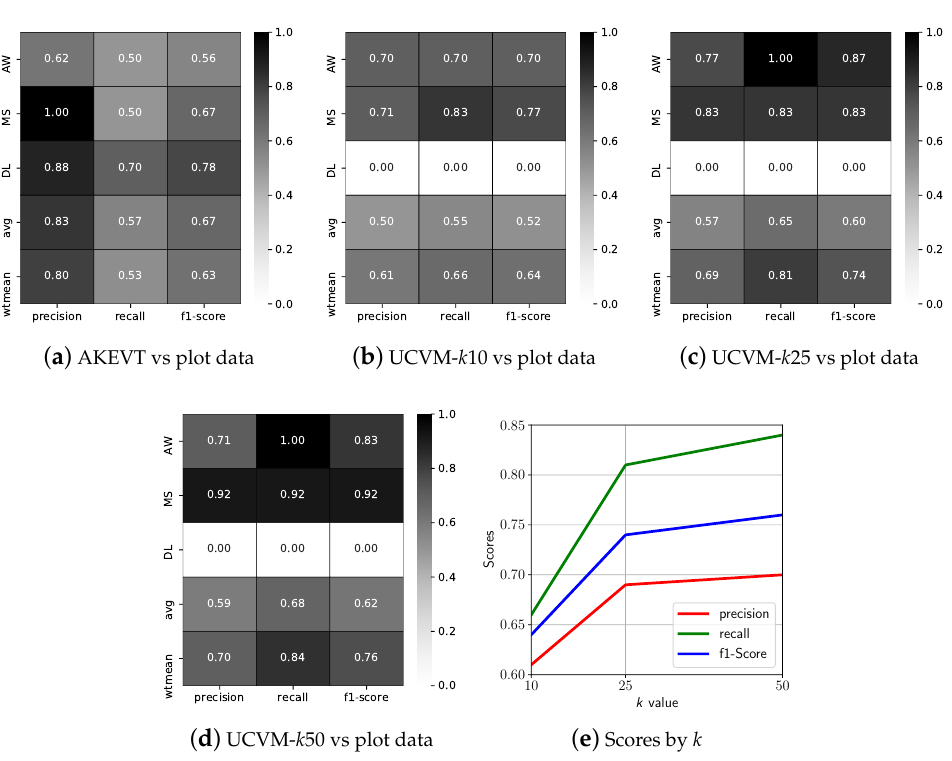
( a ) AKEVT vs plot data ( c ) UCVM- k 25 vs plot data